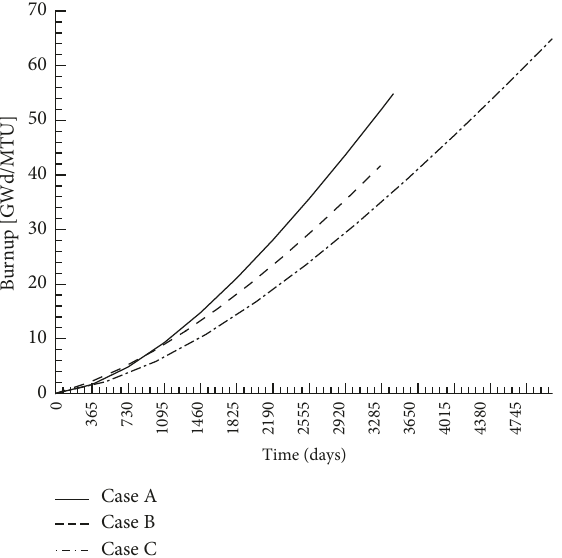
Figure 5: Increase in burnup during the operation times.